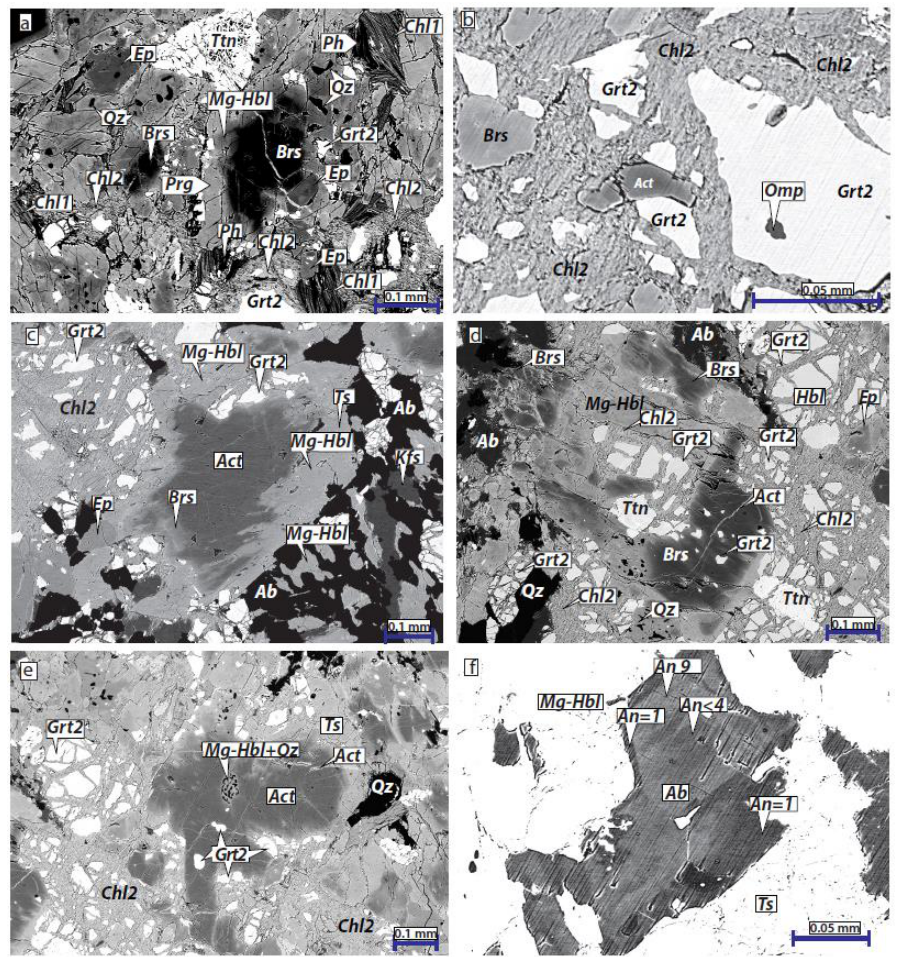
Figure 5. images from the amphibolitized eclogite (MG1220-2). ( a ) A large grain zoned amphibole coexist with phengite (Ph), chlorite (Chl1), epidote (Ep), and titanite (Ttn). Amphibole have a core of barroisite with overgrown rim zoned with Mg-hornblende and pargasite. Relics of fragmental garnets (Grt2), amphibole and darker flakes of Chl1 are surrounded by fine-grained aggregates of chlorite (Chl2); ( b ) Fragmental garnet (Grt2), barroisite, actinolite are surrounded by Chl2. Grt2 contain inclusion of omphacite (Cpx1); ( c ) Resorbed core zoned with actinolite to barroisite overgrown by Mg-hornblende and tschermakite (Ts). Discrete anhedral and subhedral smaller Mg-hornblende are forming symplectite texture together with plagioclase and K-feldspar; ( d ) Partially resorbed core of amphibole contains inclusions of fragmental garnet (Grt2). During the resorbtion Chl2 surround the amphibole and infiltrated into the core of amphibole and partially replaced inclusions of Grt2. Amphibole zoned as barroisite resorbed core with Mg-hornblende rim. Albite (Ab), epidote, and quartz coexist with Mg-hornblende. Thin actinolite micro-vein cross cut zoned amphibole; ( e ) Fragmental garnet (Grt2) strongly replaced by Chl2. Core of actinolite contain symplectitic polyphase inclusion of Mg-hornblende and quartz, probably indicating former omphacite; ( f ) Symplectitic plagioclase have a zoning with anorthite content increase from the core (An = 4) to the mantle (An = 9) and decrease from the mantle to the rim (An =